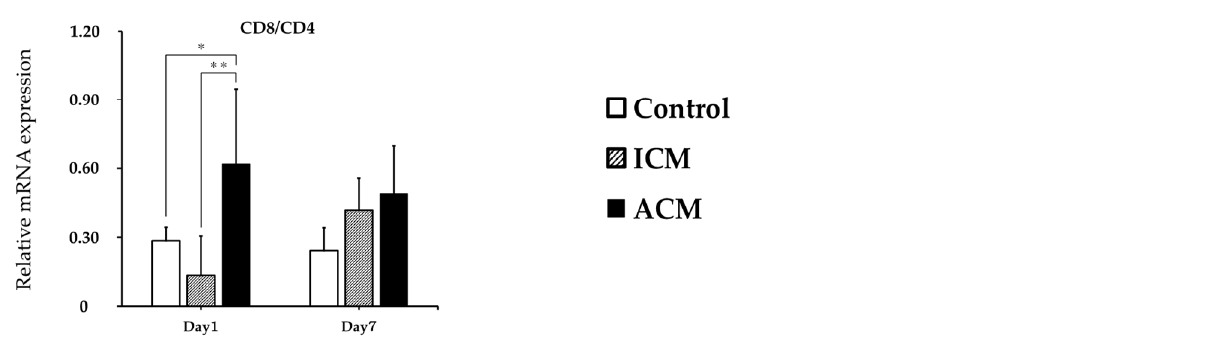
Figure 3. mRNA expression of T ‐ cell phenotypes in the oral mucosa of Cr ‐ induced allergic mice. At Days 1 and 7 post ‐ challenge, the mRNA expression of CD3, CD4, CD8, and the CD8/CD4 ratio in the oral mucosa was evaluated (n = 8). The expression of the GAPDH gene served as an internal control. The mean and standard deviation are represented by bars and error bars. Kruskal–Wallis and Dunn’s multiple comparison tests were used to determine statistical significance (* p < 0.05, ** p < 0.01).